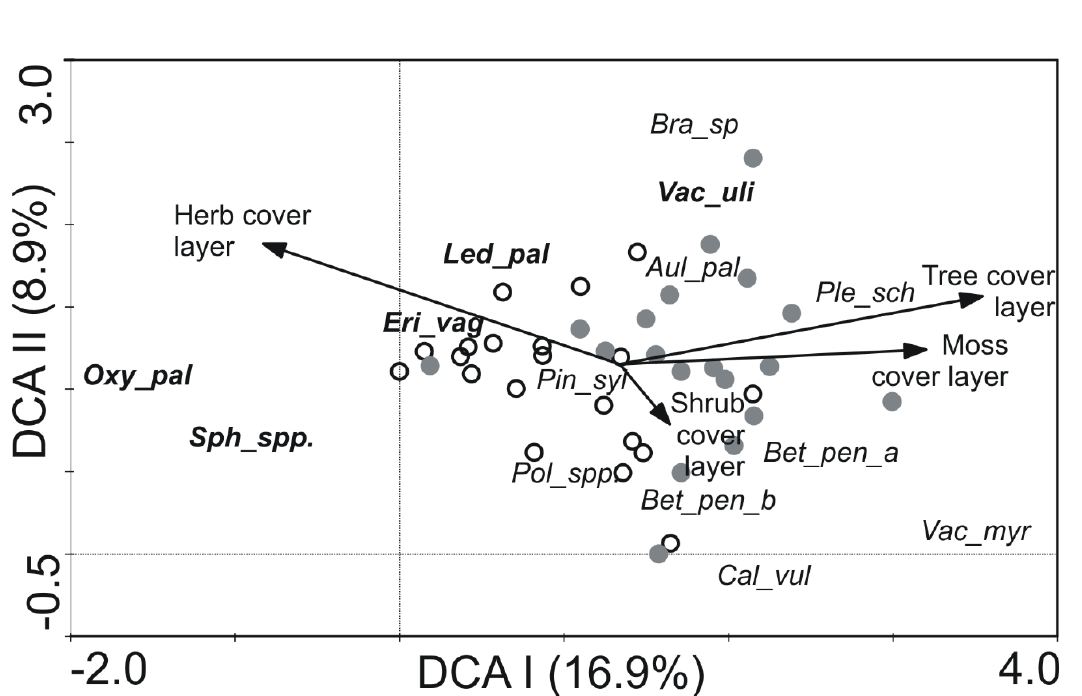
Figure 3. Unconstrained ordination diagram (DCA) of plots (filled circles - Sector A, unfilled circles - Sector B) and vegetation data. Only raised bog species (in bold ) and species with the highest weight are presented. Abbreviations of species names: Aul_pal = Aulacomnium palustre, Bet_pen_a = Betula pendula in tree layer, Bet_pen_b = Betula pendula in shrub layer, Bra_spp. = Brachythecium species, Cal_vul